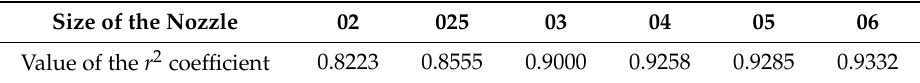
Table 1. The values of correlation and determination coe ffi cient for the E ˙ZK nozzle.